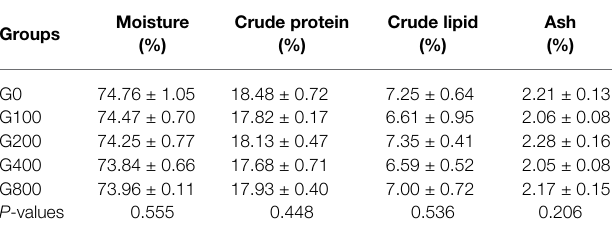
TABLE 4 | Effects of dietary GSH on body composition of O. mykiss (mean ± SD, n = 12).